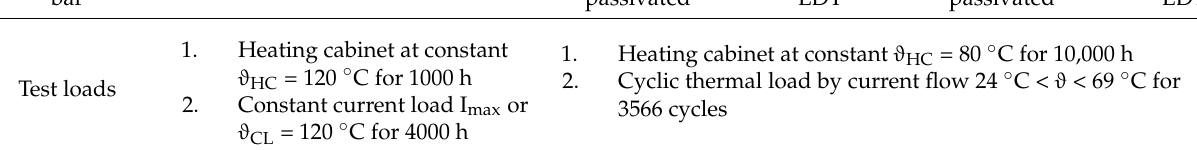
Figure 7. Cross-section and surface conditions of the self-piercing studs [20].